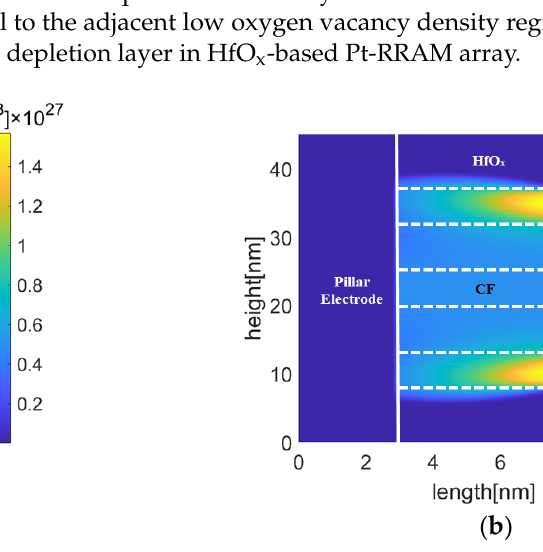
Figure 11. Oxygen vacancy distributions in Pt-RRAM arrays with the spacing of 7 nm ( a ) TiO x ( b ) HfO x .